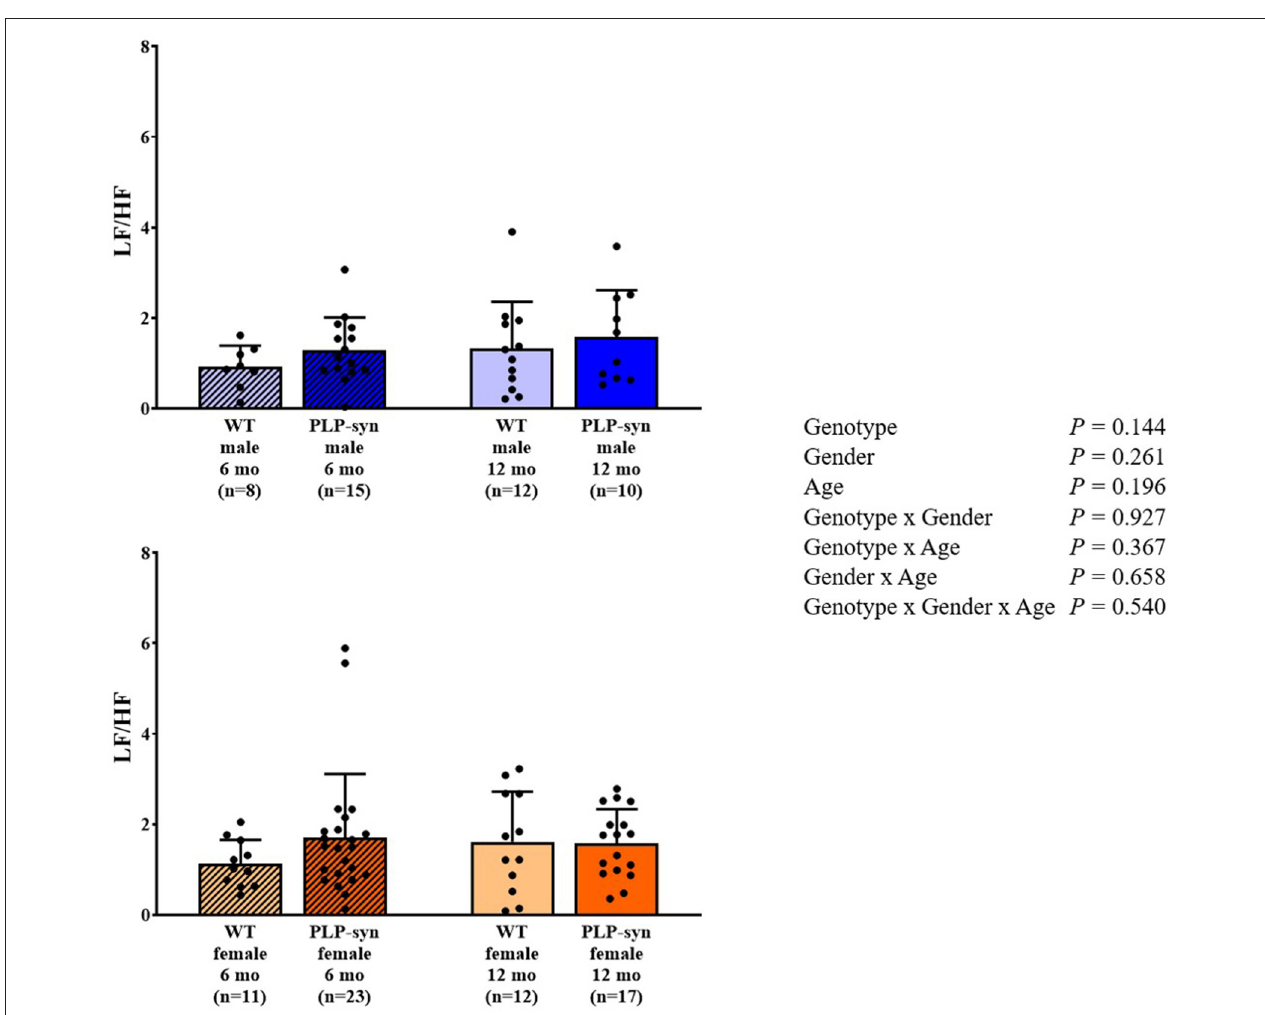
FIGURE 5 | LF/HF power in 6 and 12 months, male and female, WT and PLP- α -syn mice.